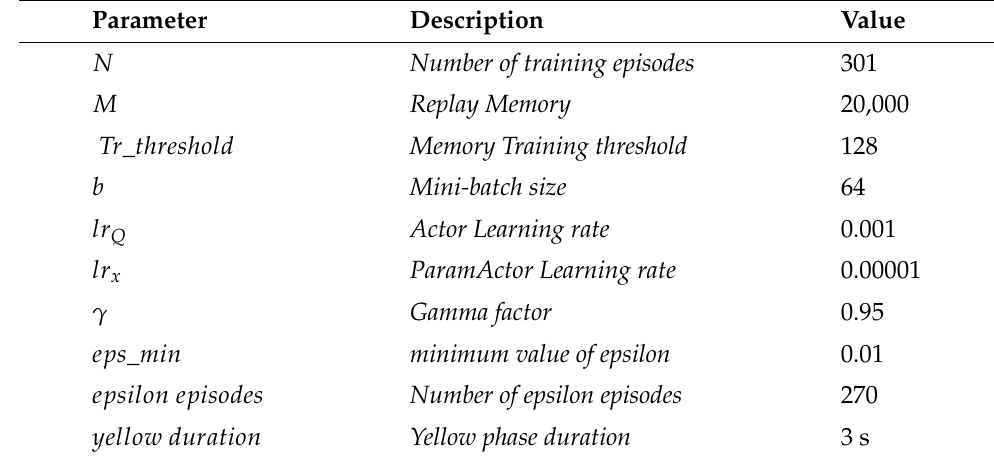
Table 2. Parameters Setting for Agent